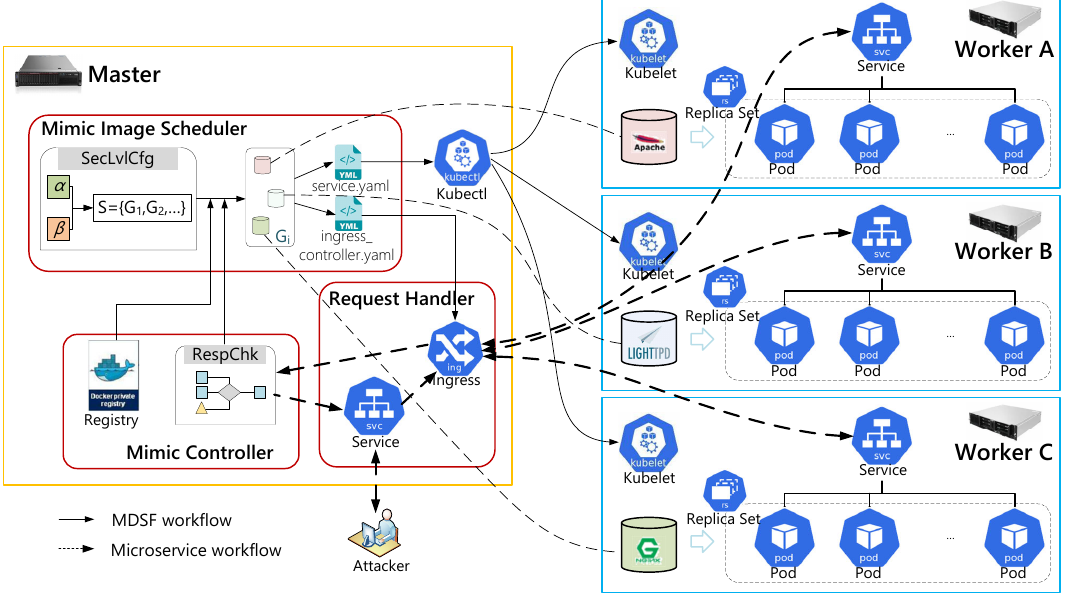
Figure 5. The systematic implementation of MDSF. The icons in blue are Kubernetes native compo- nents, and modules in red boxes are the developed